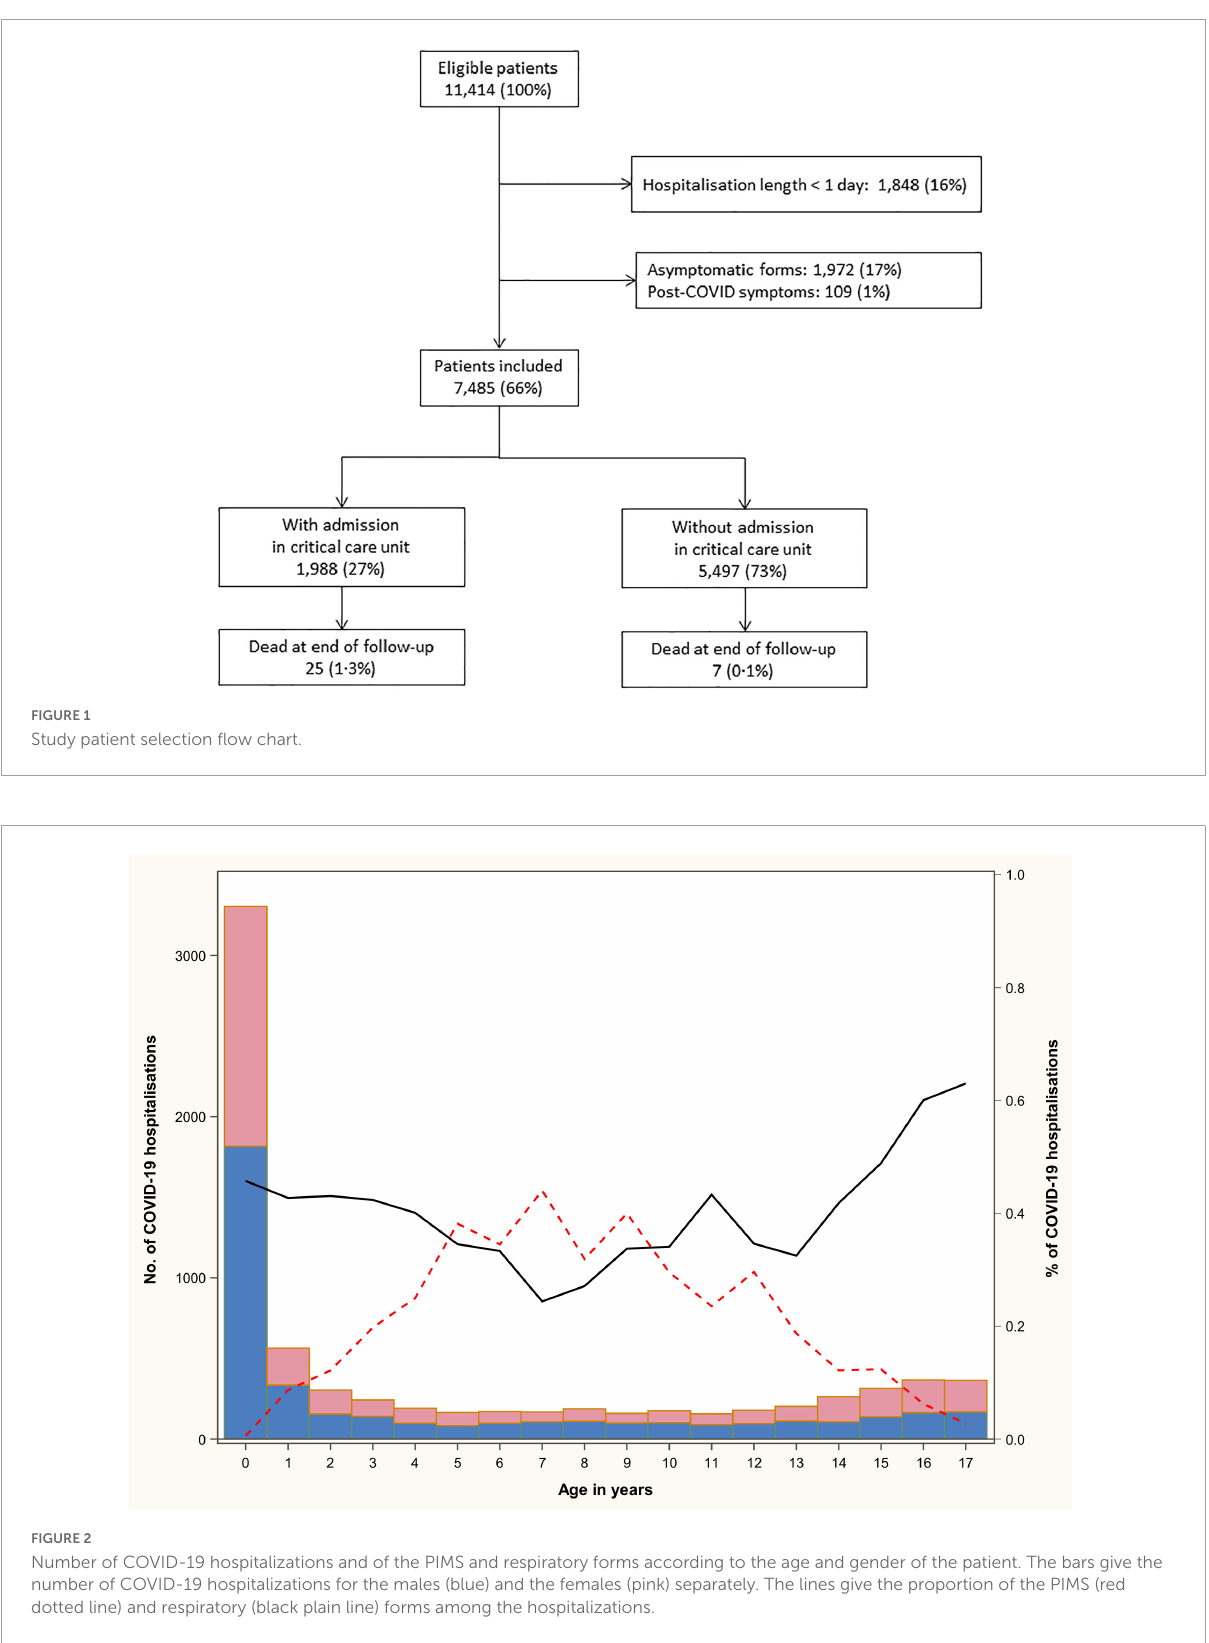
FIGURE2 Number of COVID-19 hospitalizations and of the PIMS and respiratory forms according to the age and gender of the patient. The bars give the number of COVID-19 hospitalizations for the males (blue) and the females (pink) separately. The lines give the proportion of the PIMS (red dotted line) and respiratory (black plain line) forms among the